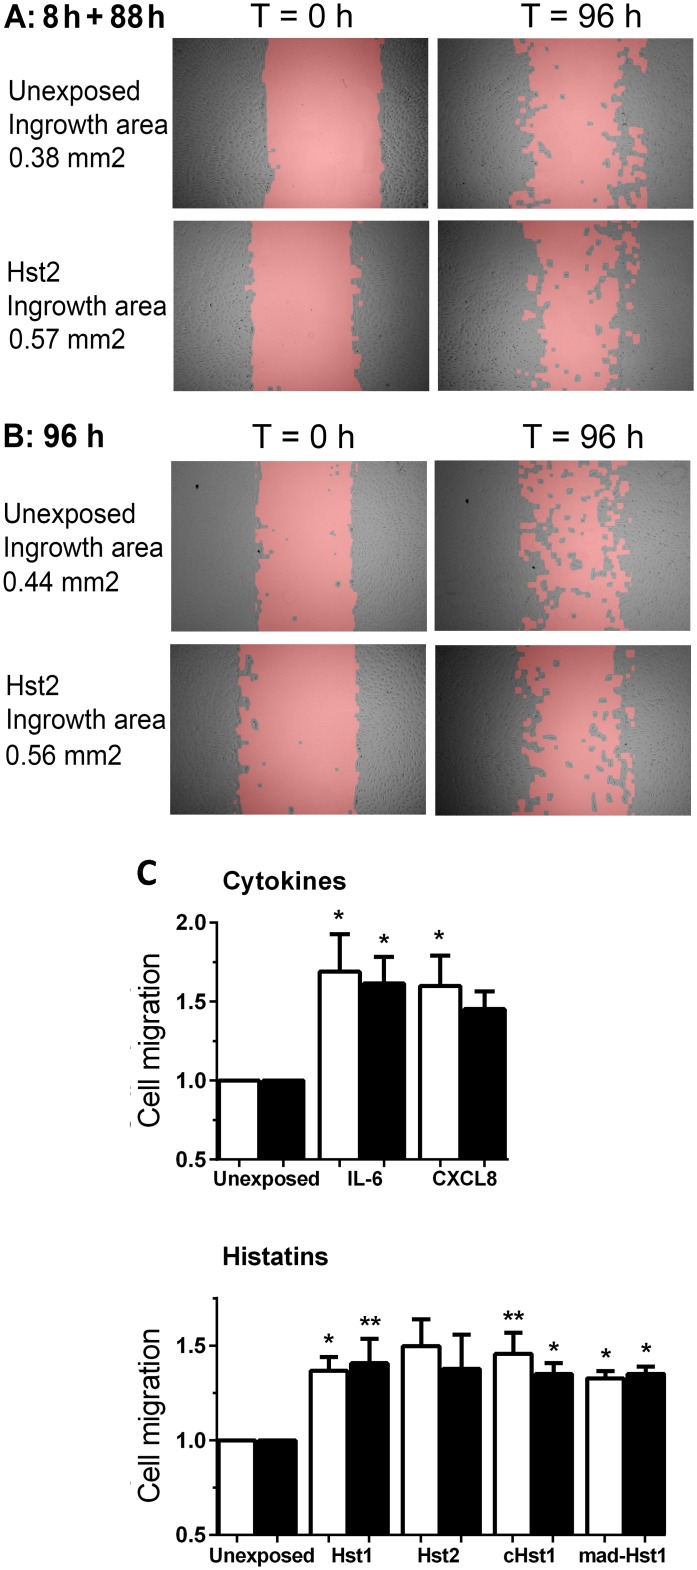
An 8 h pulse of peptides stimulates fibroblast migration to the same extent as continuous 96 h exposure.Migration of dermal fibroblasts in a scratch wound healing assay is shown. At time of introduction of the scratch into a confluent layer of dermal fibroblasts, cultures were supplemented with the peptides Hst1 (5 μM), Hst2 (5 μM), cHst1 (5 μM), mad-Hst1 (5 μM), rhIL-6 (125 ng/ml), rhCXCL8 (250 ng/ml) and vehicle (H2O). A, B: Representative photographs of fibroblasts in the scratch wound healing assay at 0 h (left pictures) and 96 h (right pictures) after culture. Cells were unexposed (upper two pictures) or exposed to Hst2 (lower two pictures) for 96 h (A) or for 8 h after which medium was changed to peptide free medium for the remaining 88 h (B). C: Migration in the scratch wound healing assay. White bars = 8 h exposure with peptides, followed by 88 h incubation without peptides, black bars = 96 h continuous exposure with peptides. Bars represent means ± SEM of three independent experiments each performed in quadruplicate. * P <0.05, ** P <0.01, *** P <0.005: comparison between exposure and control; no significant differences found between 8 h and 96 h of exposure. At 96 h the extent of migration (area covered) was determined with an image processing algorithm and each culture was compared to its own 0 h time point and then set relative to the unexposed group (see extensive description in Materials and Methods).